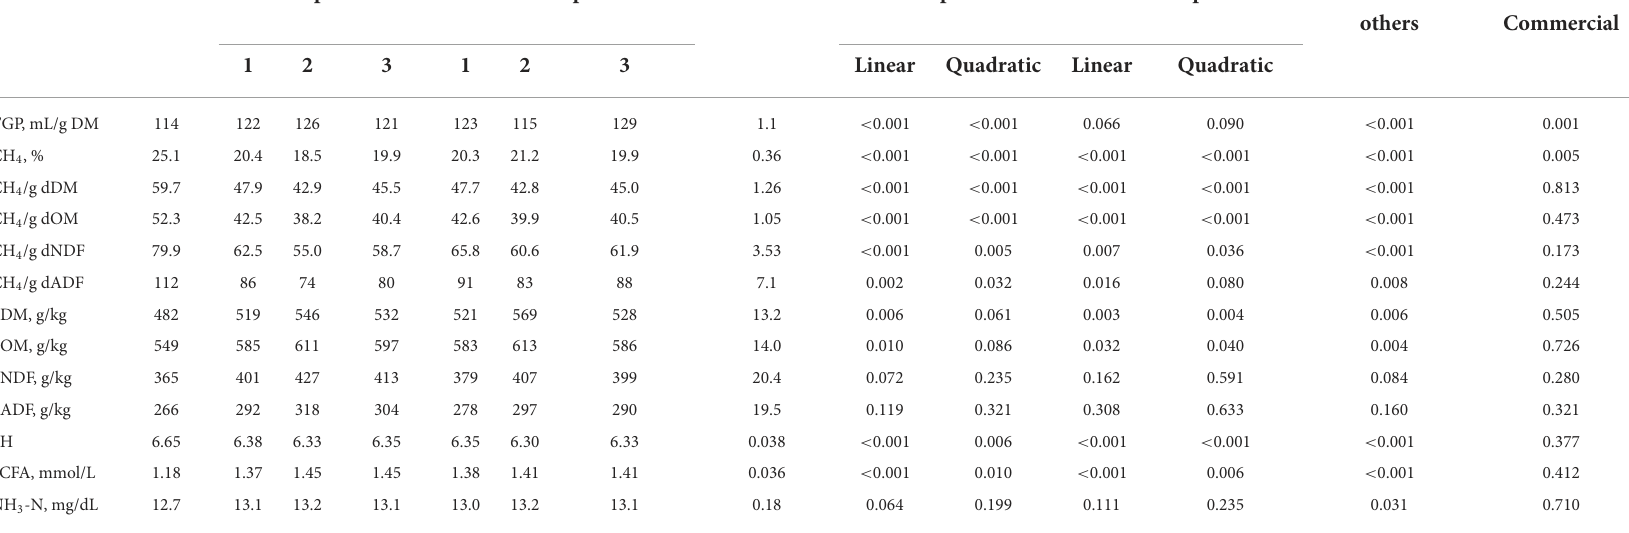
TABLE 2 In vitro fermentation from Experiment 1 (mean values), where a basal diet was supplemented with isolated or commercial E. faecium as probiotics at 1, 2 or 3 g/kg DM. Control Pooled SEM Control vs. Isolated